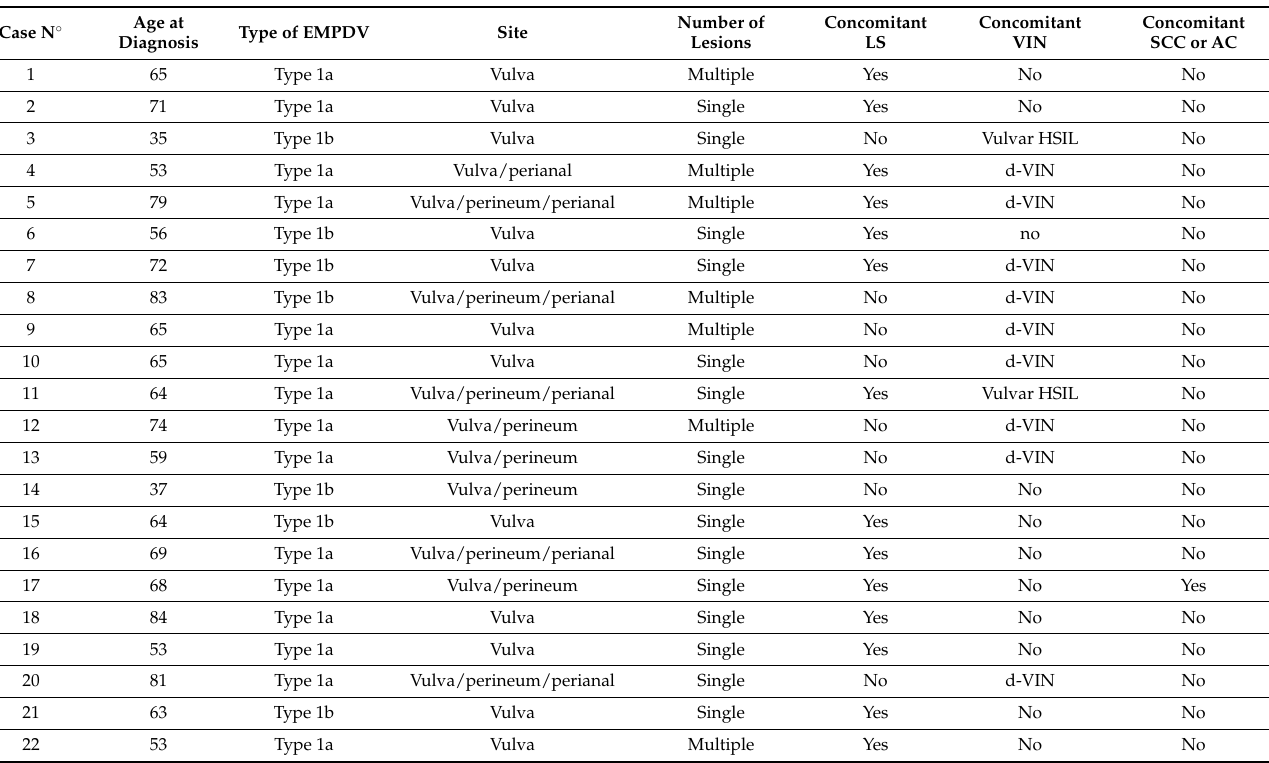
Table 1. Cases of EMPDV and concomitant vulvar cancer and